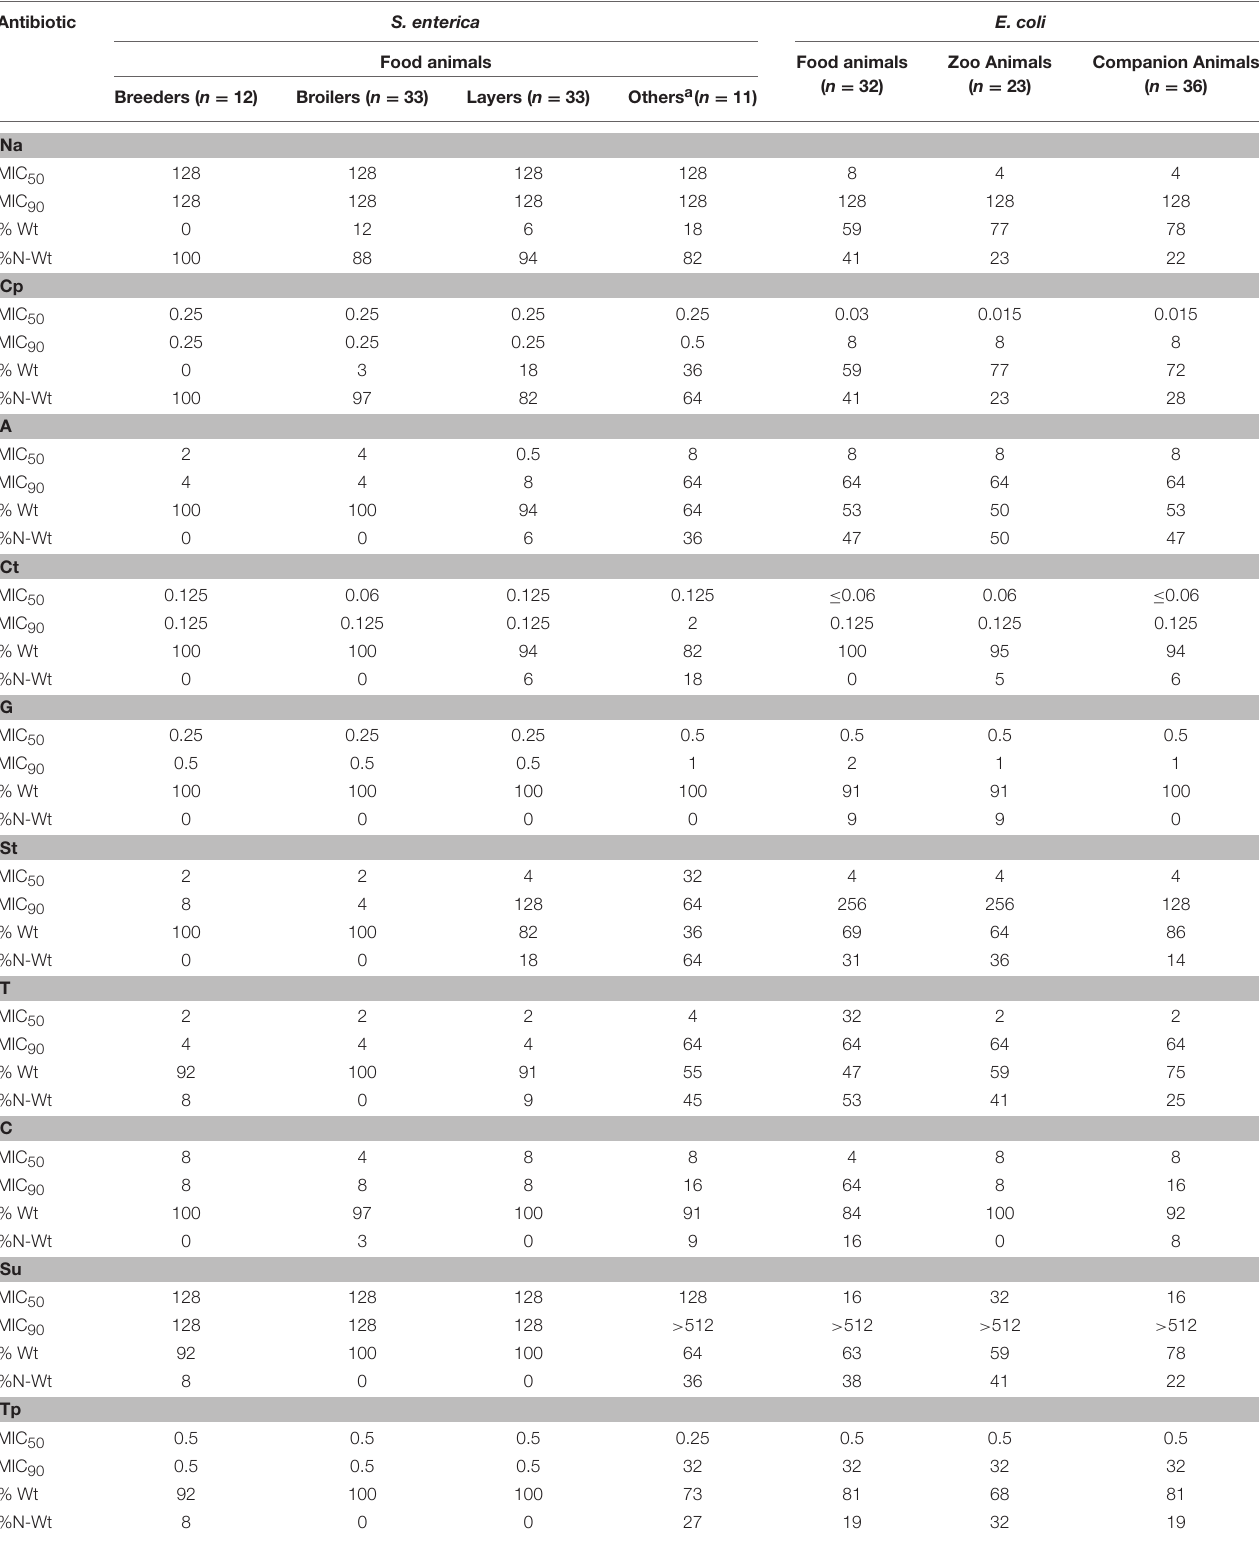
TABLE 2 | MIC 50 and MIC 90 for S. enterica ( n = 89) and E. coli ( n = 91) isolates.